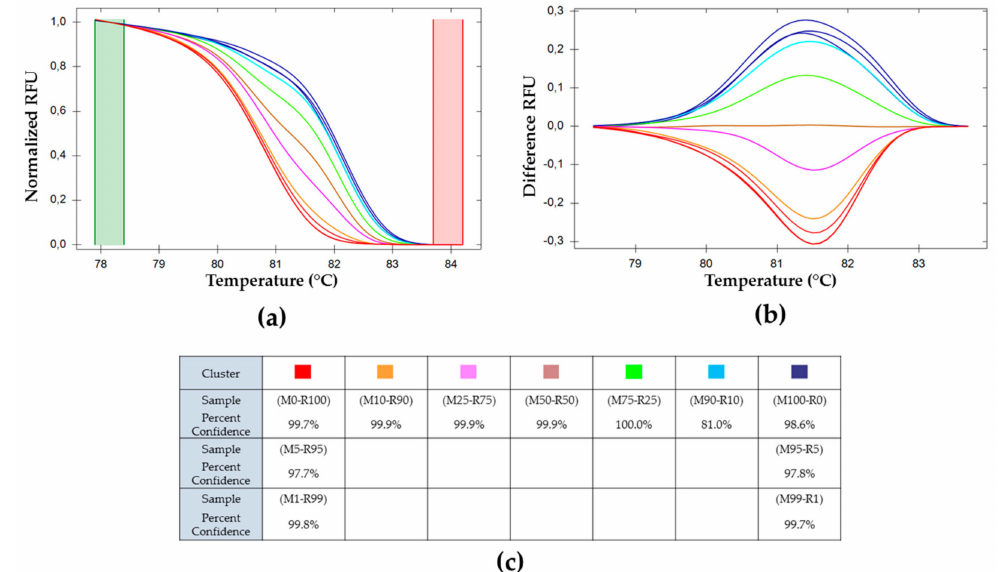
Figure 3. Melting curve analysis of pe38 amplicons in DNA mixtures. ( a ) Normalized relative fluorescence unit (RFU) variation with temperature, ( b ) plot of deviations of RFU related to M50-R50 used as a reference with varying temperatures and ( c ) percent of confidence for each cluster. ( ) (M0-R100), (M99-R1), and (M95-R5); ( ) (M100-R0), (M1-R99) and (M5-R95); ( ) (M90-R10); ( ) (M75-R25); ( ) (M50-R50); ( ) (M25-R75); ( )